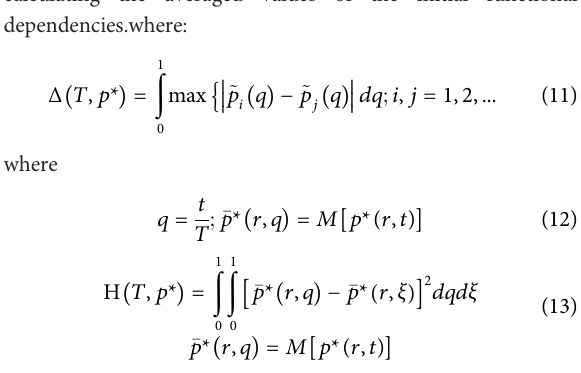
FIGURE 1 Innovation index dynamics in climate change in 2014 – 2021 in Belgium.